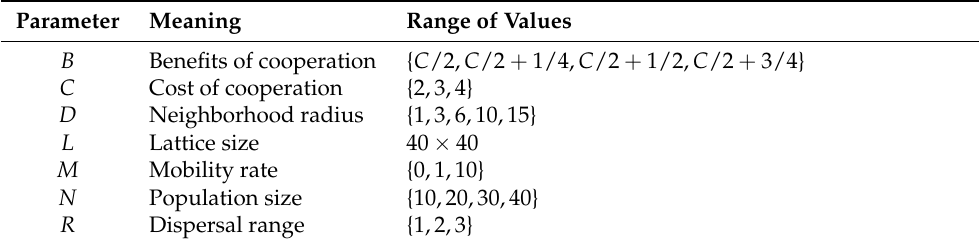
Table 1. Summary of the model parameters